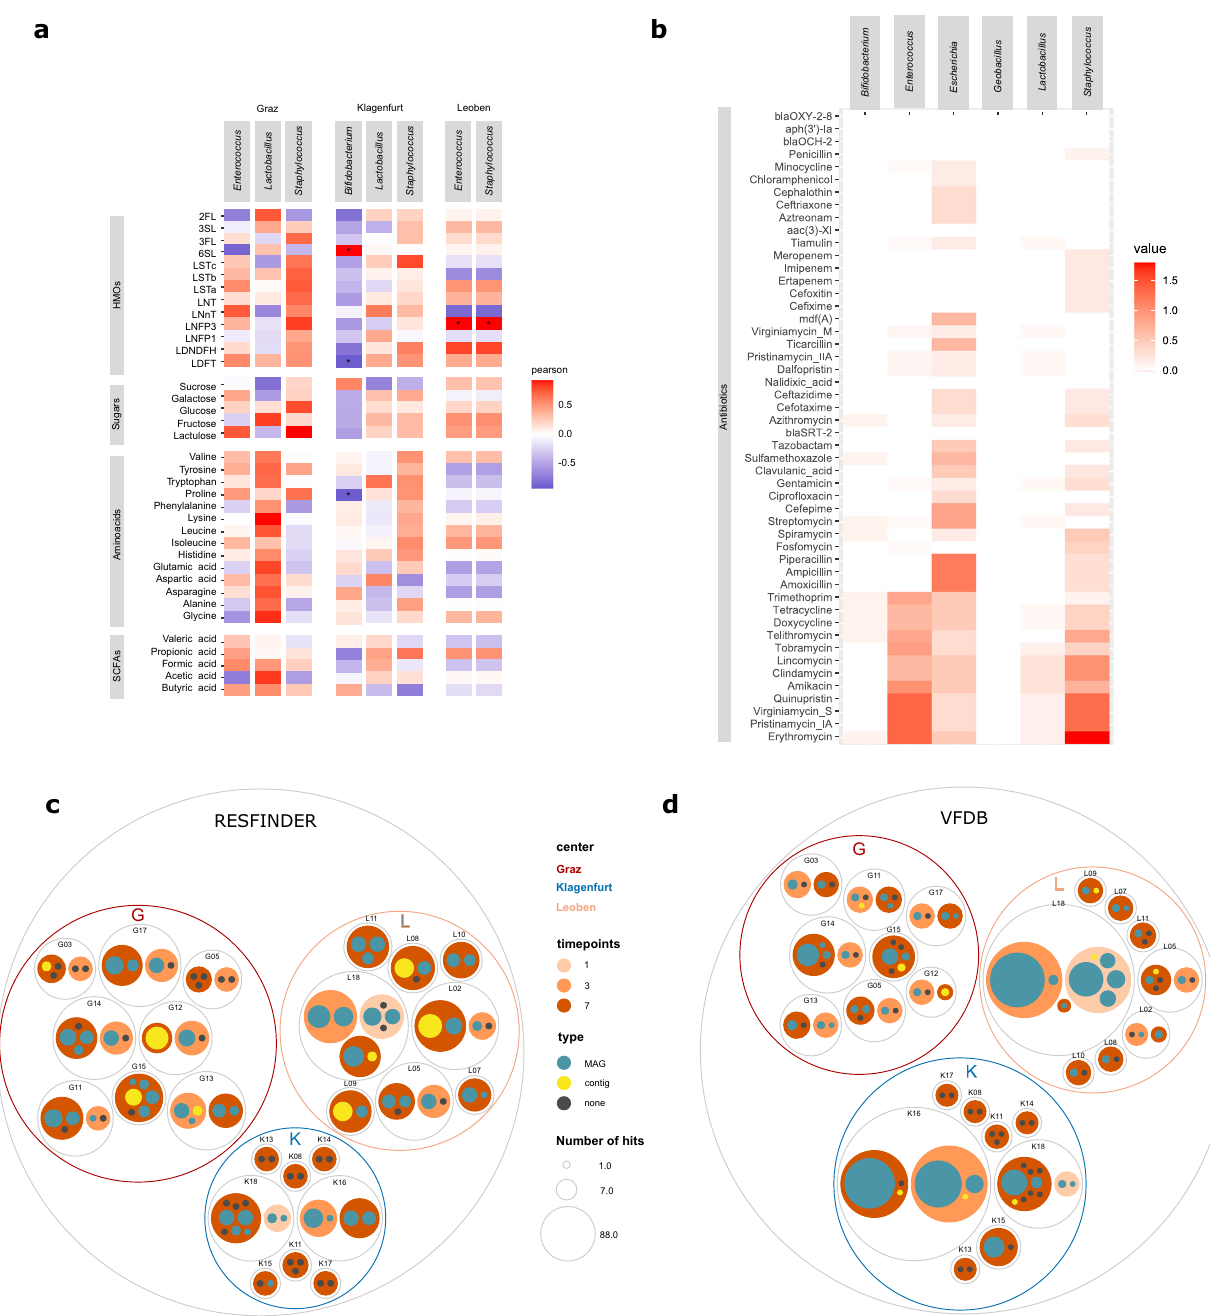
Fig. 5 | Results of taxonomic correlation analyses and distribution patterns of metabolites, antibiotic resistances and virulence factors. a Metabolites mea- sured with NMR correlated with bacterial key genera in the three centers; meta- bolites of the groupsofhumanmilk oligosaccharides (HMOs),sugars, amino acids andshort-chainfattyacids(SCFAs); b correlationofantibioticresistancegeneswith bacterial key genera. Circle packing plot of c resistance genes and d virulence factorsinthecenters.EachcirclerepresentsaninfantandissplitintothethreeMGS